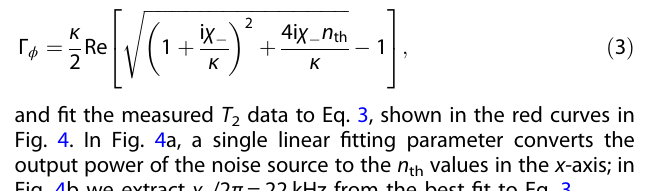
Fig. 3 Qubit readout when χ − ≈ 0. Two consecutive Gaussian pulses with σ = 16 ns and frequencies ω − , ω + − α c are sent to drive qubit transitions, followed by a readout pulse at the cavity frequency ω r . a Homodyne readout signal shows Rabi oscillations for both 〉 ↔ | 1 〉 and | 1 〉 ↔ | 1 〉 transitions, with Rabi angles | 0 − 0 + − 0 + − 0 + − 1 + θ 1,2 determined by the amplitudes of the two drive pulses. b Horizontal cuts at θ 2 = 0 and π in a . Maximum readout contrast ( red crosses ) is obtained after transferring | 1 − 0 + 〉 to | 1 − 1 + 〉 by a transfer pulse with θ 2 = π , in contrast to very low readout signal ( blue dots ) with no transfer pulse. The pulse sequence is shown in the